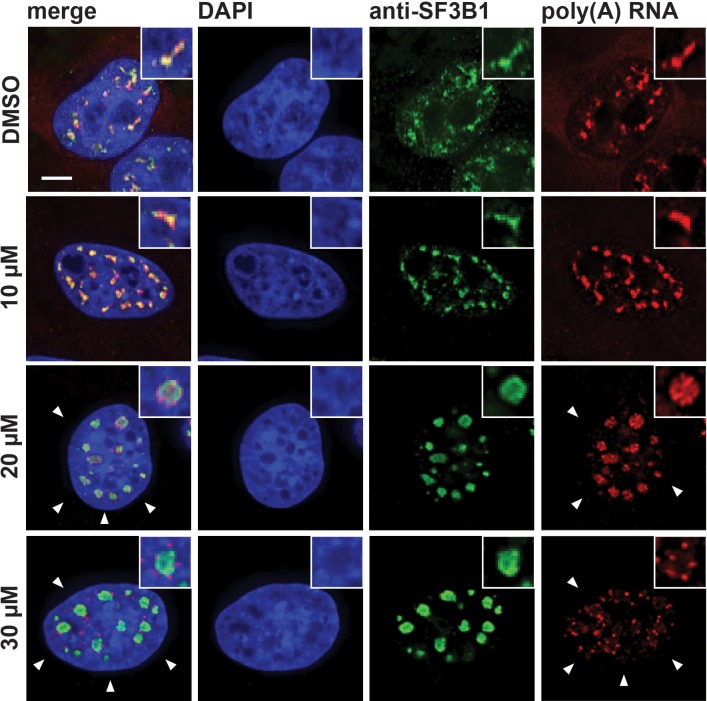
Hinokiflavone affects localization of polyadenylated RNA.HeLa cells were incubated for 24 hr with either DMSO, or 10 µM, 20 µM, or 30 µM hinokiflavone and the fixed cells were hybridized with Cy3 labelled Oligo dT probes and co-stained with anti-SF3B1. Treatment with 30 µM hinokiflavone leads to a relocation of polyadenylated RNA from the enlarged splicing speckles to dots at their periphery. Scale bars, 6.5 µm.